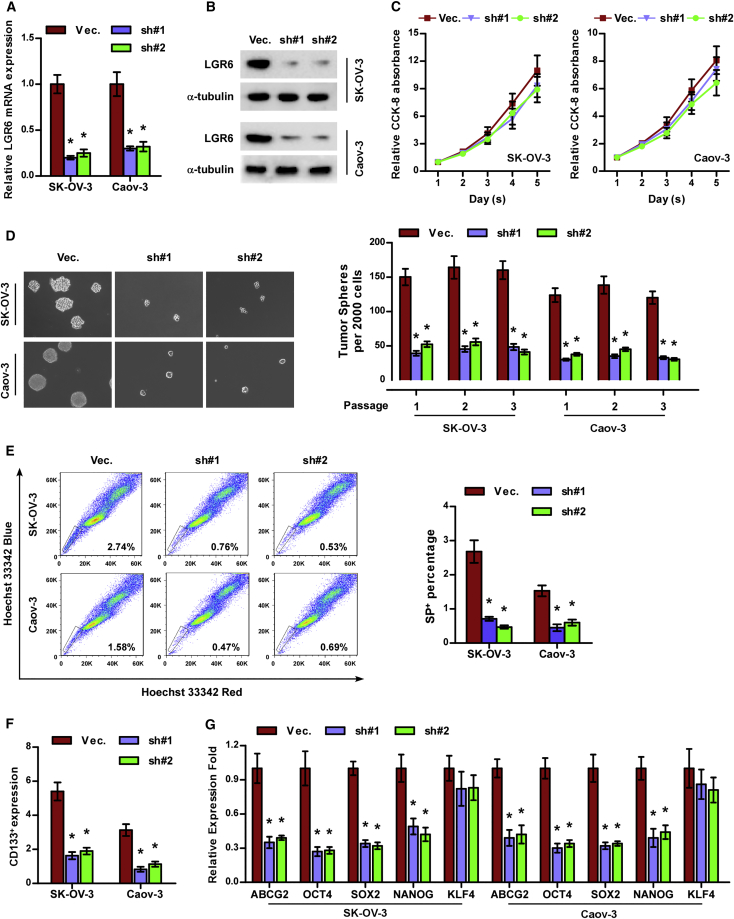
Silencing LGR6 Represses CSC Characteristics in Ovarian Cancer Cells In Vitro(A and B) Real-time PCR (A) and western blotting (B) analysis of LGR6 expression in the indicated ovarian cancer cells. GAPDH was used as an endogenous control in RT-PCR, and α-tubulin was detected as a loading control in the western blot. Error bars represent the mean ± SD of three independent experiments. *p < 0.05. (C) The effect of LGR6 silencing on proliferation of ovarian cancer cells via CCK-8 assay. Error bars represent the mean ± SD of three independent experiments. (D) The effect of LGR6 silencing on spheroid formation ability of ovarian cancer cells. Error bars represent the mean ± SD of three independent experiments. *p < 0.05. (E and F) The effect of LGR6 silencing on SP+ (E) and CD133+ (F) population of ovarian cancer cells via flow cytometry. Error bars represent the mean ± SD of three independent experiments. *p < 0.05. (G) Real-time PCR of ABCG2, OCT4, SOX2, NANOG, and KLF4 expression in the indicated ovarian cancer cells. GAPDH was used as endogenous control. Error bars represent the mean ± SD of three independent experiments. *p < 0.05.